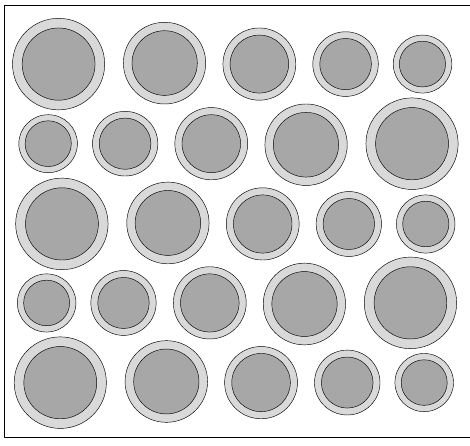
Figure 6. Hybrid cell structure CMUT model diagram.